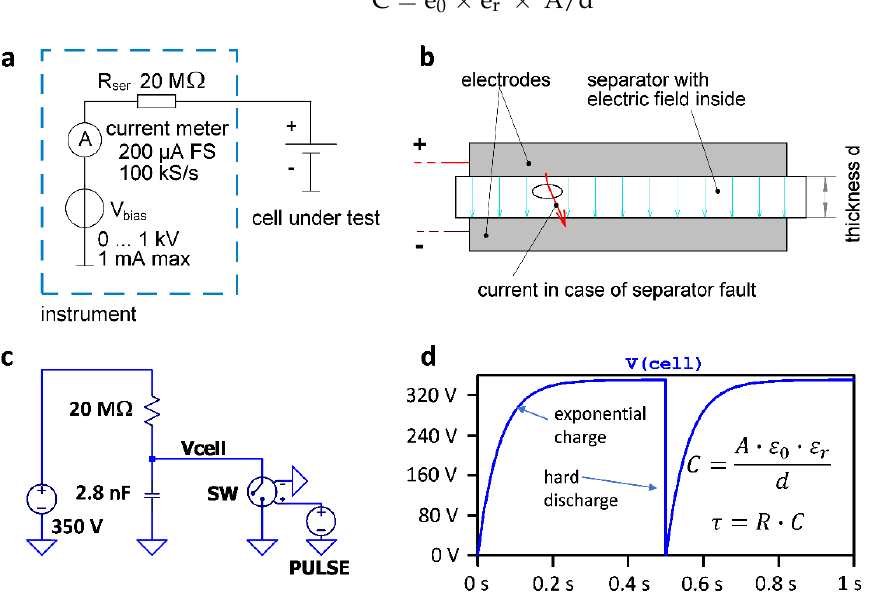
Figure 1. Measurement scheme and electric circuitry modeling. ( a ) Electrical scheme of the current- meter connected to the cell under test (CUT). ( b ) Sketch of the separator sandwiched between two conducting electrodes. ( c ) SPICE simulation circuitry with a voltage-controlled switch for the fast discharge. ( d ) Modeled exponential rise of the voltage over time with an abrupt discharge at 0.5 s.